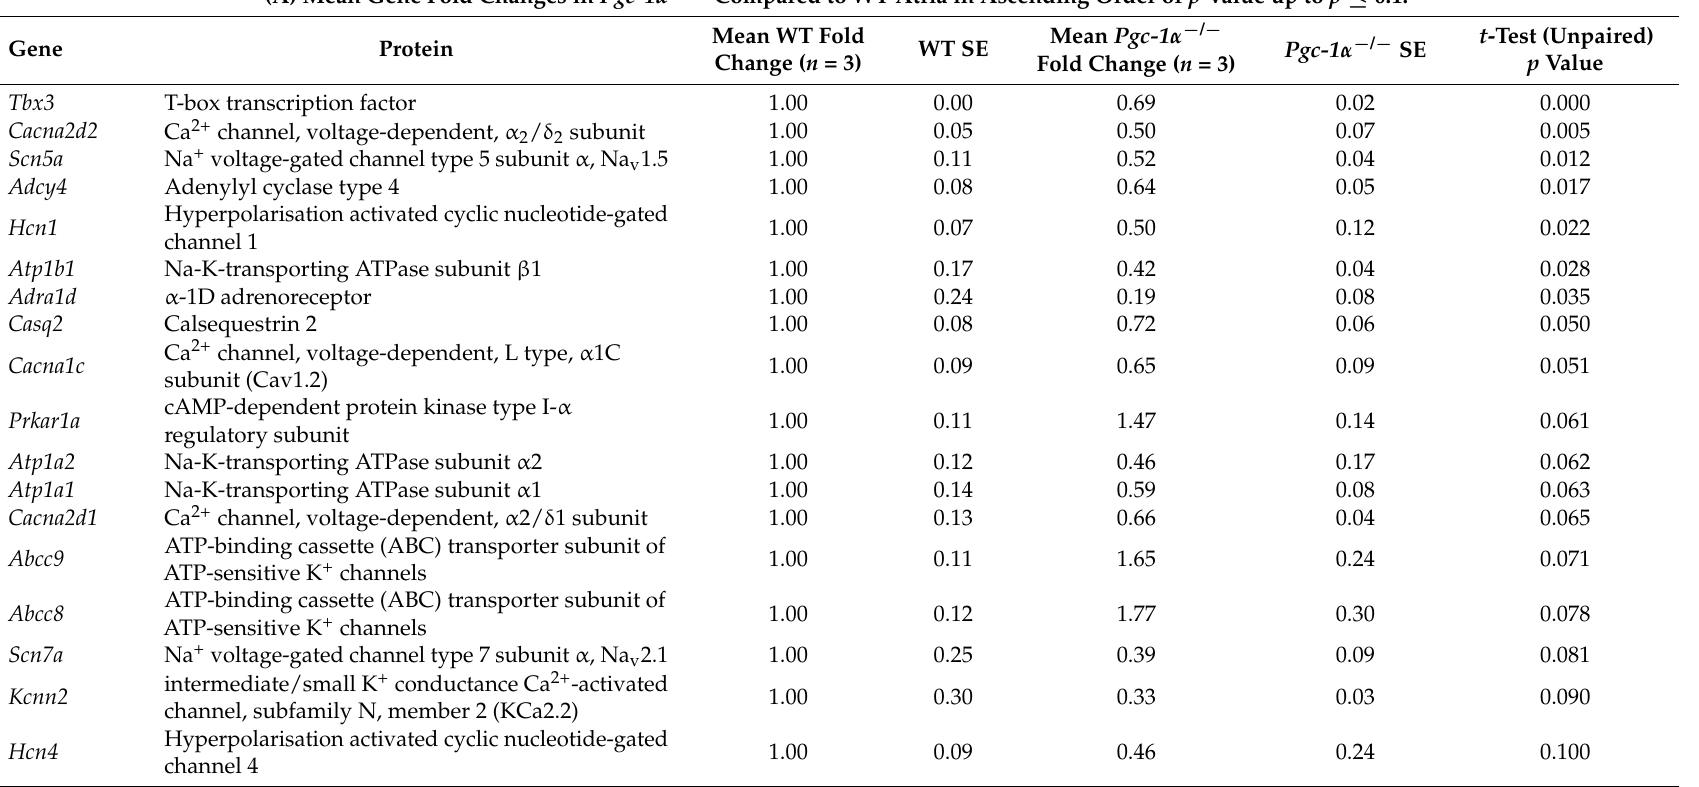
Table 9. Stratifications of mean gene fold changes in Pgc-1 α − / − compared to WT atria. (A) Mean Gene Fold Changes in Pgc-1 α − / − Compared to WT Atria in Ascending Order of p Value up to p ≤